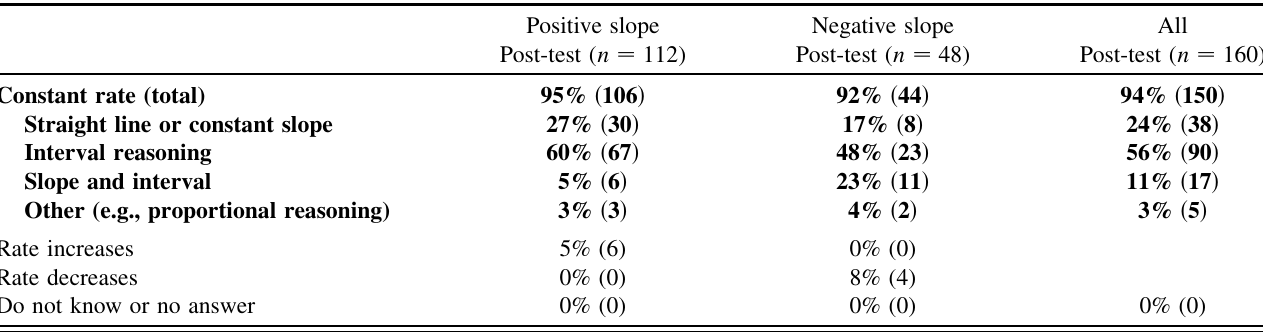
TABLE IX. Post-test results for the question whether the water level is changing at an increasing, decreasing, or constant rate. No significant difference was found between positively and negatively sloped lines.